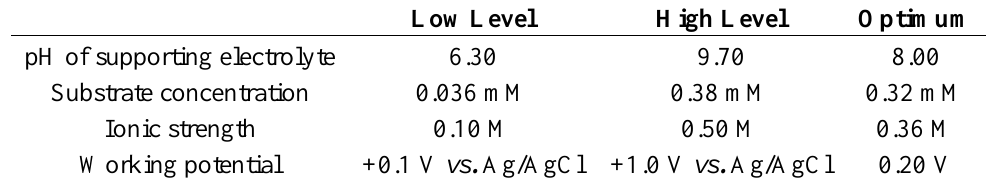
Table 1. Values corresponding to high (+) and low (–) levels for each factor, used to optimize experimental conditions for tungsten detection.